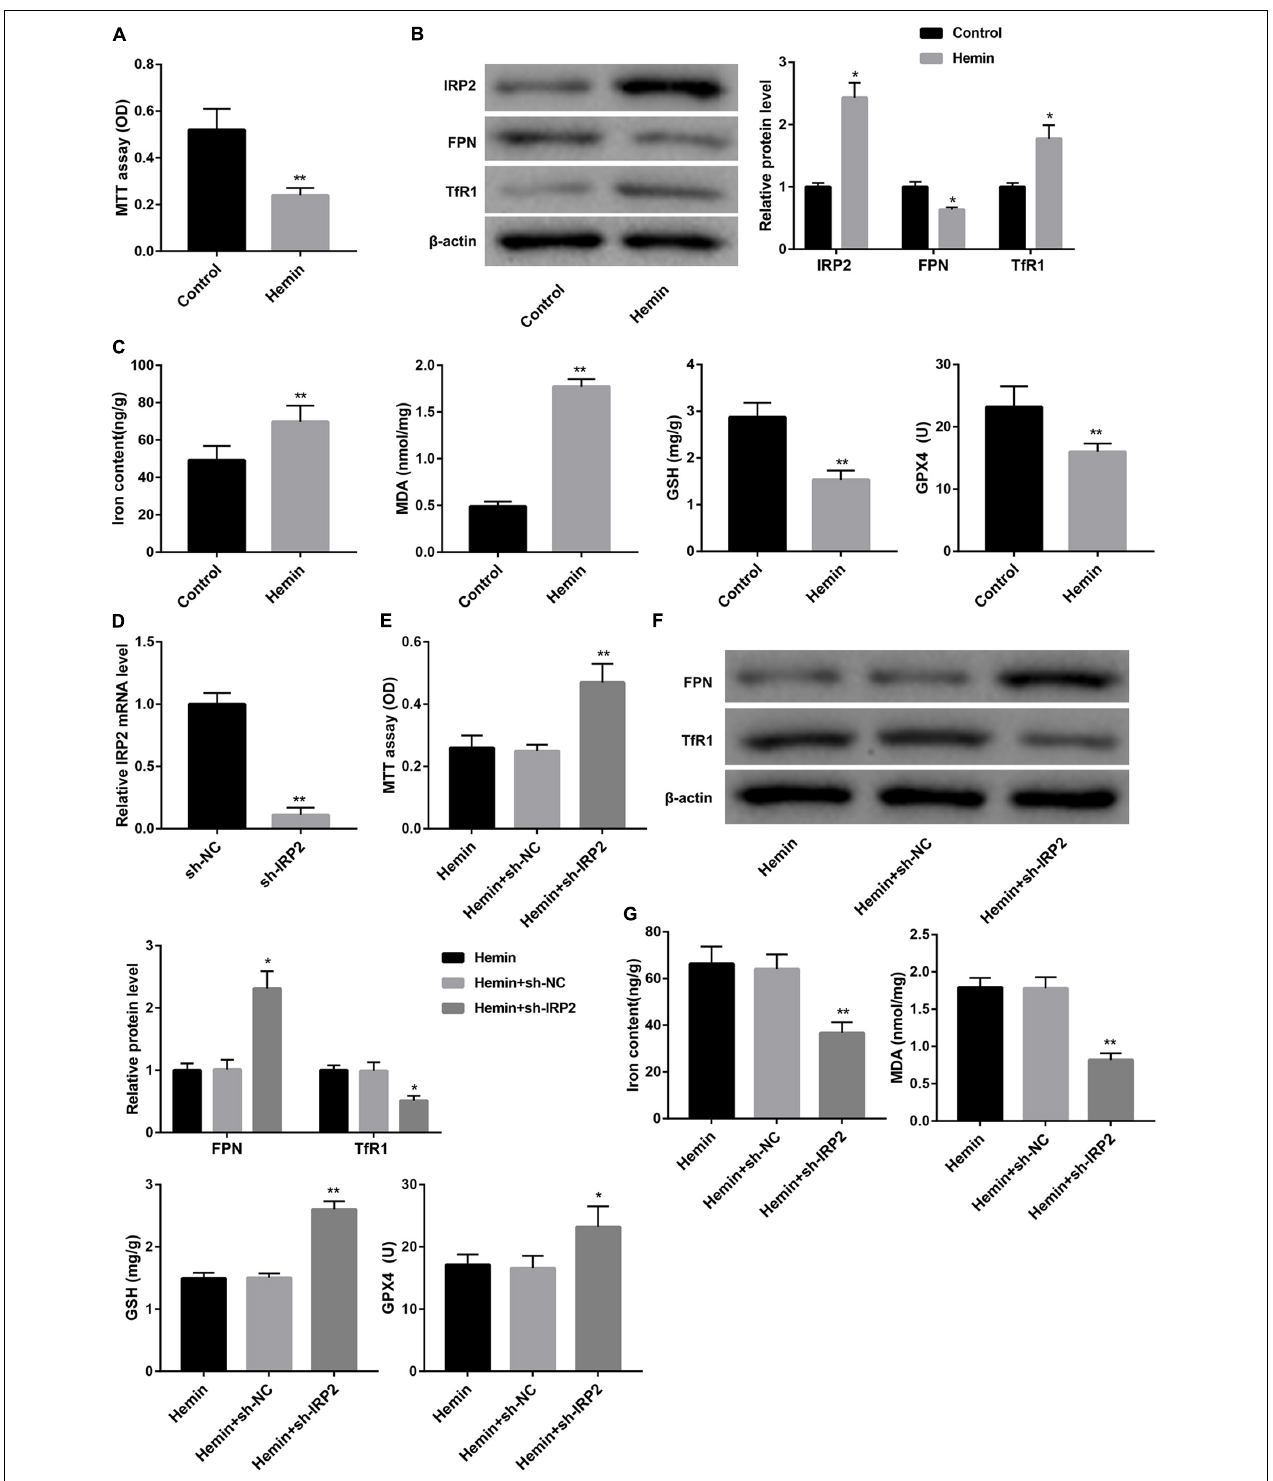
FIGURE 2 | IRP2 silencing attenuated hemin-induced ferroptosis in primary neurons in vitro . (A) Cell viability examined MTT assay, (B) western blot analysis of IRP2, TfR1, and FPN, and (C) levels of iron, MDA, GSH, and GPX4 in the primary cortical neurons which were treated with hemin (100 µ M) or saline for 24 h. (D) Relative IRP2 mRNA level determined by qRT-PCR, (E) cell viability examined MTT assay, (F) western blot analysis of TfR1 and FPN, and (G) levels of iron, MDA, GSH, and GPX4 in the primary cortical neurons which were transfected with sh-IRP2 or sh-NC and treated with hemin (100 µ M) for 24 h. The data are presented as the mean ± standard deviation ( n = 3). * P < 0.05, ** P < 0.01, vs. Control or Hemin+sh-NC.